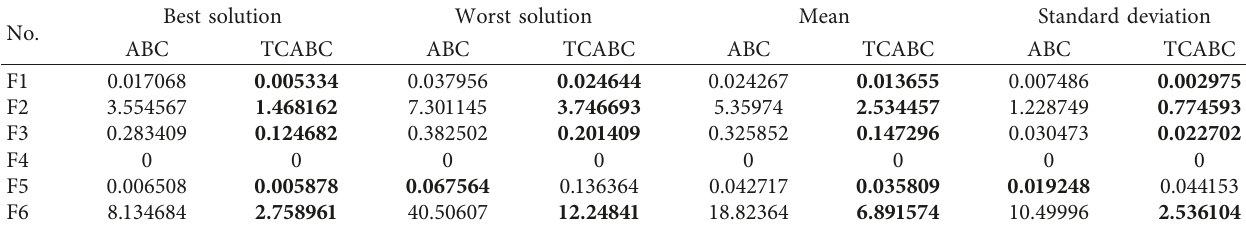
Table 2: Performance comparison between ABC and TCABC algorithms.